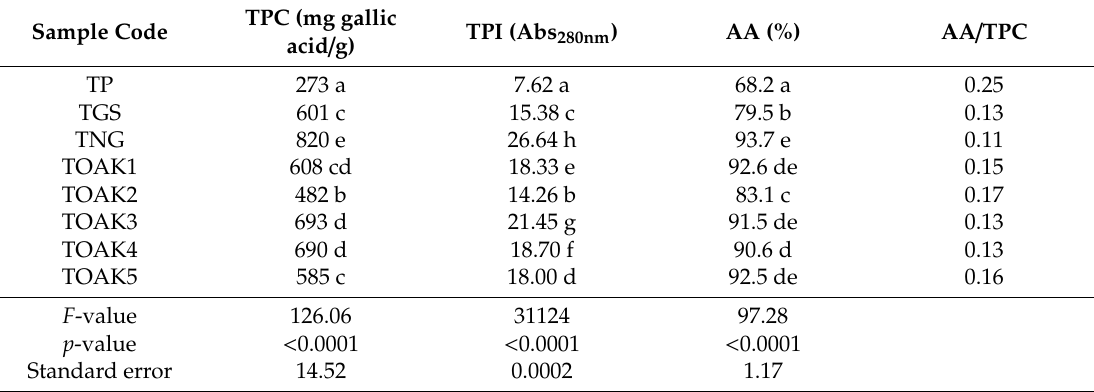
Table 2. Antioxidant and antiradical activity of the analyzed tannins dissolved in the model wine solution. TPC: total phenolic content; TPI, total polyphenolic index; AA, antiradical activity evaluated using 2,2-diphenyl-1-picrylhydrazyl. Data are expressed as mean of three determinations; in each column, di ff erent letters (a–f) indicate statistically significant di ff erences. F -values, p -values, and standard errors of means are also